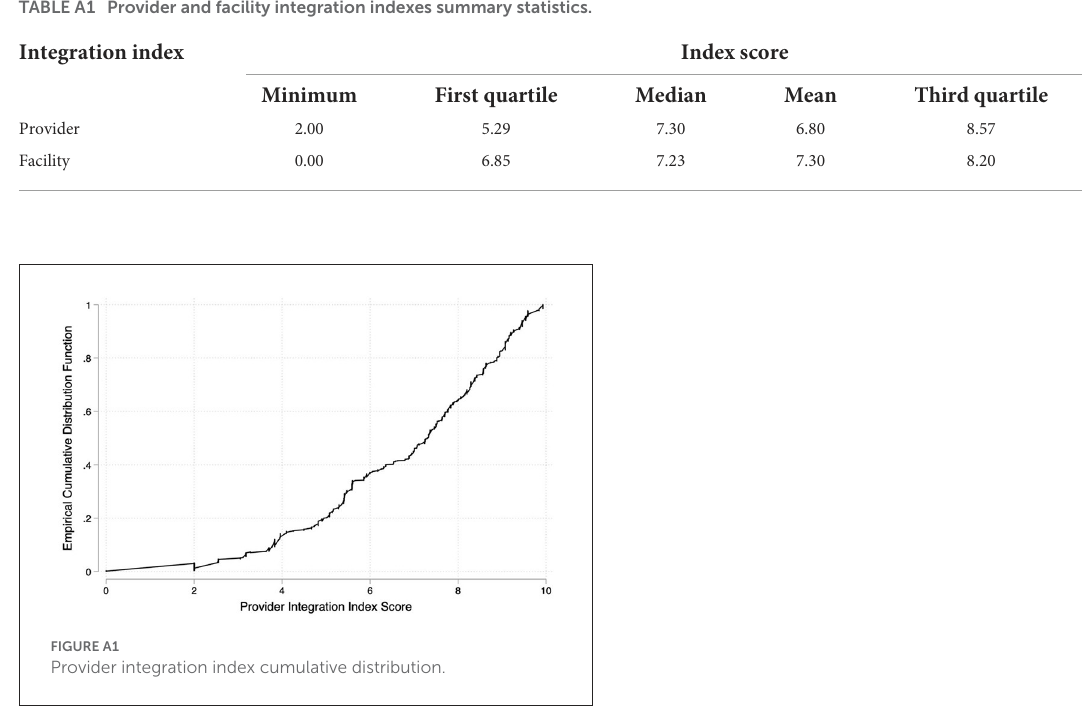
TABLE A1 Provider and facility integration indexes summary statistics.